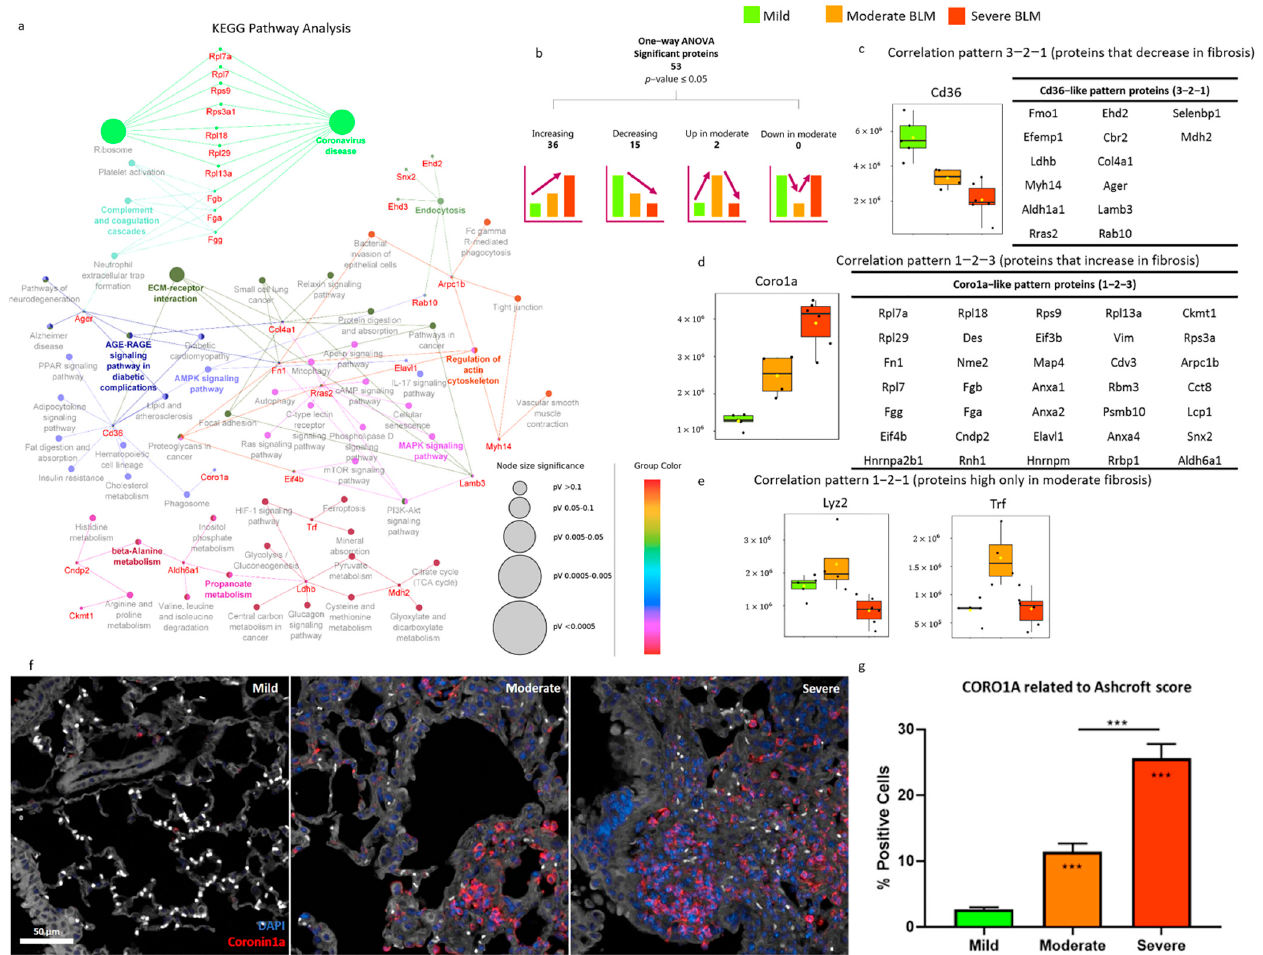
Figure 4. Fibrosis progression in bleomycin ‐ treated mice: mild, moderate, and severe. ( a ) Cytoscape network of KEGG Pathways obtained including in the analysis all the 53 proteins statistically significant in the one ‐ way ANOVA; ( b ) summary of one ‐ way ANOVA statistically significant proteins and with a statistically significant correlation pattern; ( c ) Cd36 boxplot as an example of the correlation pattern 3 ‐ 2 ‐ 1 and a list of all the other ANOVA statistically significant proteins with a statistically significant correlation pattern; ( d ) Coro1a boxplot as an example of the correlation pattern 1 ‐ 2 ‐ 3 and a list of all the other ANOVA statistically significant proteins with a statistically significant correlation pattern; ( e ) boxplots of the proteins Lyz2 and Trf, characterized by the correlation pattern 1 ‐ 2 ‐ 1; and ( f ) representative immunofluorescence microphotographs of lung parenchyma categorized as mild, moderate, and severe (40X magnification; scale bar 50 μ m). Nuclei were visualized using DAPI (blue) and Coro1a was stained in TRITC (red); ( g ) histogram shows the percentage of Coro1a ‐ positive cells detected after the immunofluorescence reaction. The data were expressed as the percentage of Coro1a ‐ positive cells and were normalized to the total number of cells segmented and classified as mild, moderate, and severe. Asterisks inside the bars indicate statistical significance versus the corresponding control groups (*** p < 0.001), while asterisks above the bars indicate statistical significance between categories (*** p < 0.001) (one ‐ way ANOVA). In all boxplots, mild/saline boxes are colored in light green, moderate BLM are colored in light orange, and severe BLM are colored in dark orange. In all boxplots, black dots represent the abundance of the selected features in all samples, yellow diamond represents the mean abundance.KEGG: Kyoto Encyclopedia of Genes and Genomes; ANOVA: Analysis of Variance; Cd36: Platelet glycoprotein 4; Coro1a: Coronin-1A; Lyz2: Lysozyme C2; Trf: Serotransferrin; BLM: